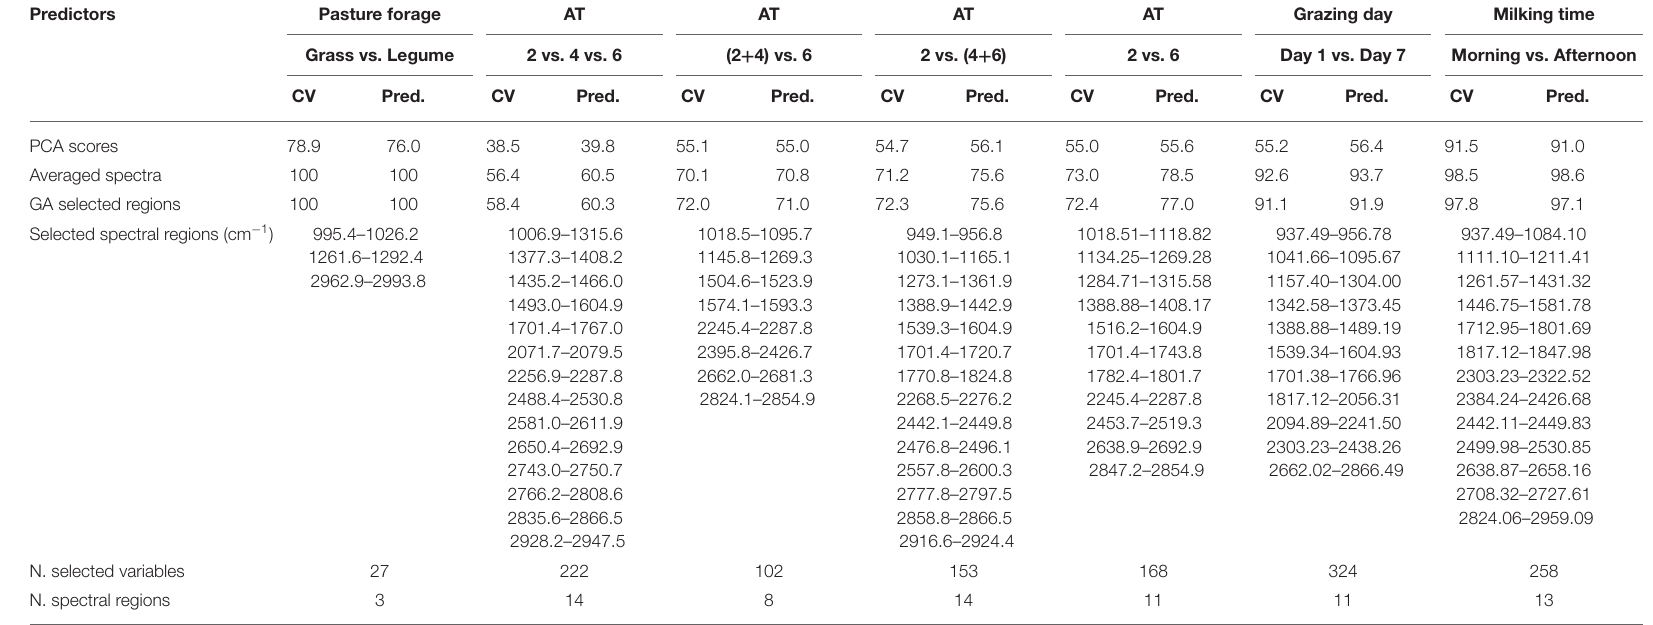
TABLE 5 | Percentage of correct classifications obtained by LDA using FT-MIR spectra as predictors. Predictors Pasture